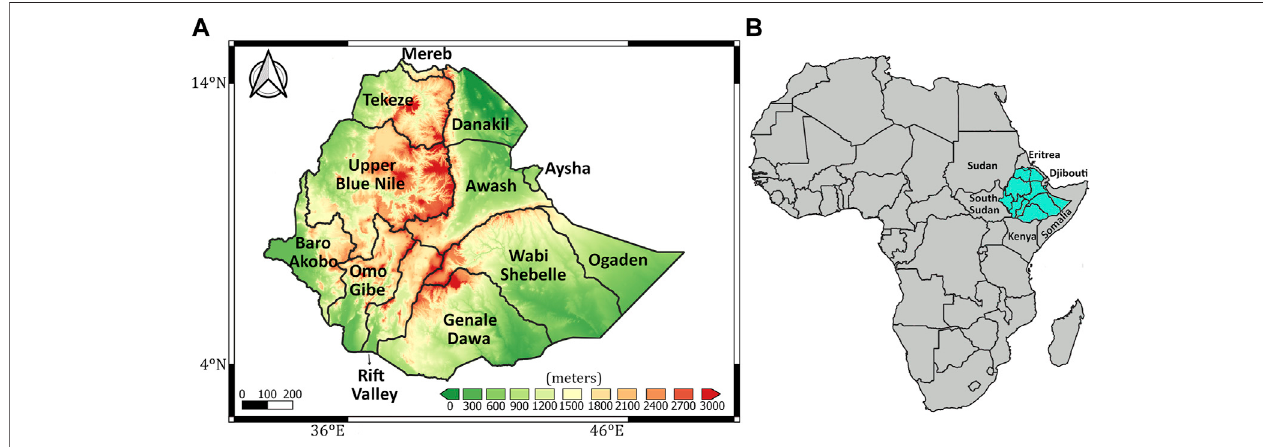
FIGURE1| Geographicallocationofthe12riverbasinsofEthiopia (A,B) ,andtheirelevation(inmetres) (A) .Elevationdataweredownloadedfromhydrologicaldata and maps based on the SHuttle Elevation Derivatives at multiple Scales (HydroSHEDS) project (available online at https://hydrosheds.org/).